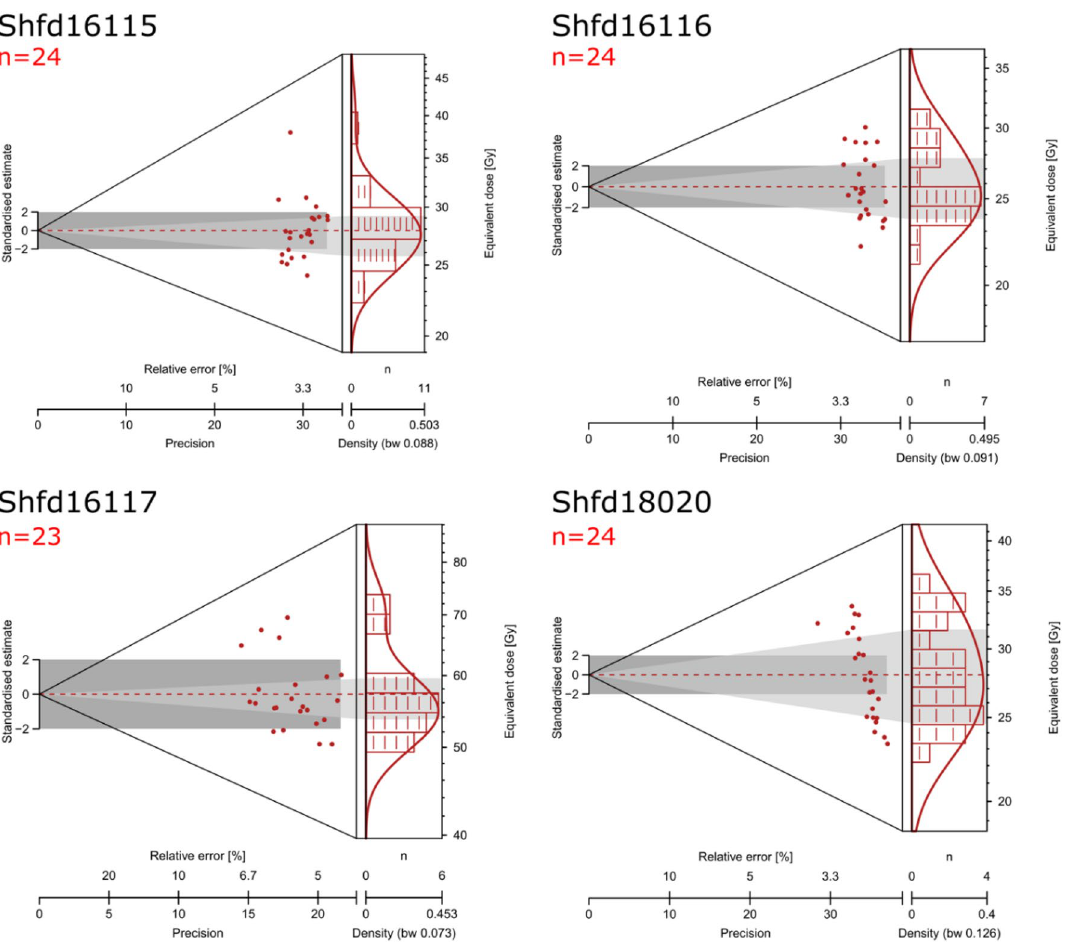
Figure 4. Abianco plots of OSL palaeodoses (De). These are shown for the three samples from Laminia (Shfd16115-17) and the sample from Saxomununya